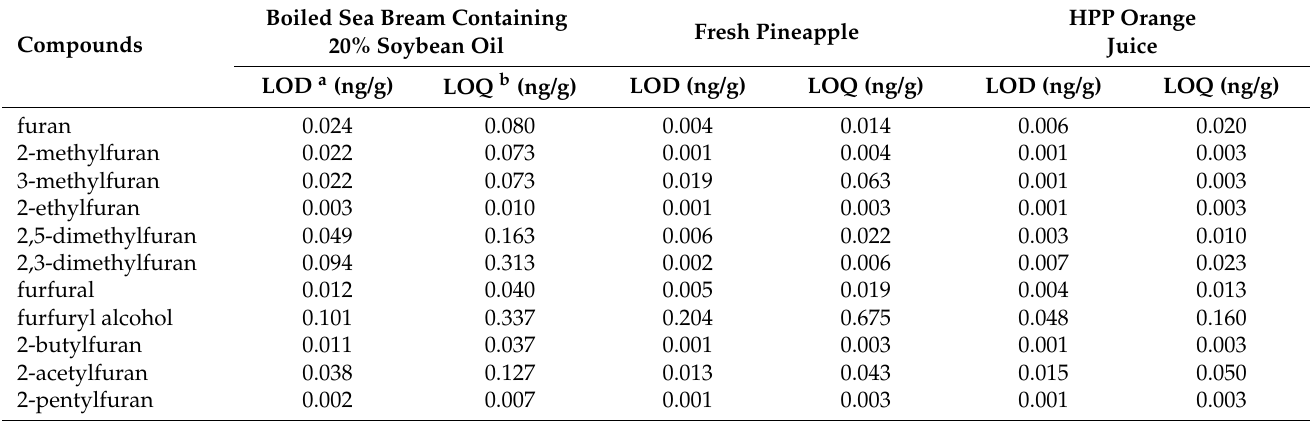
Table 3. Limit of detection (LOD), limit of quantitation (LOQ) of furan, and its derivatives in different food matrix detected by